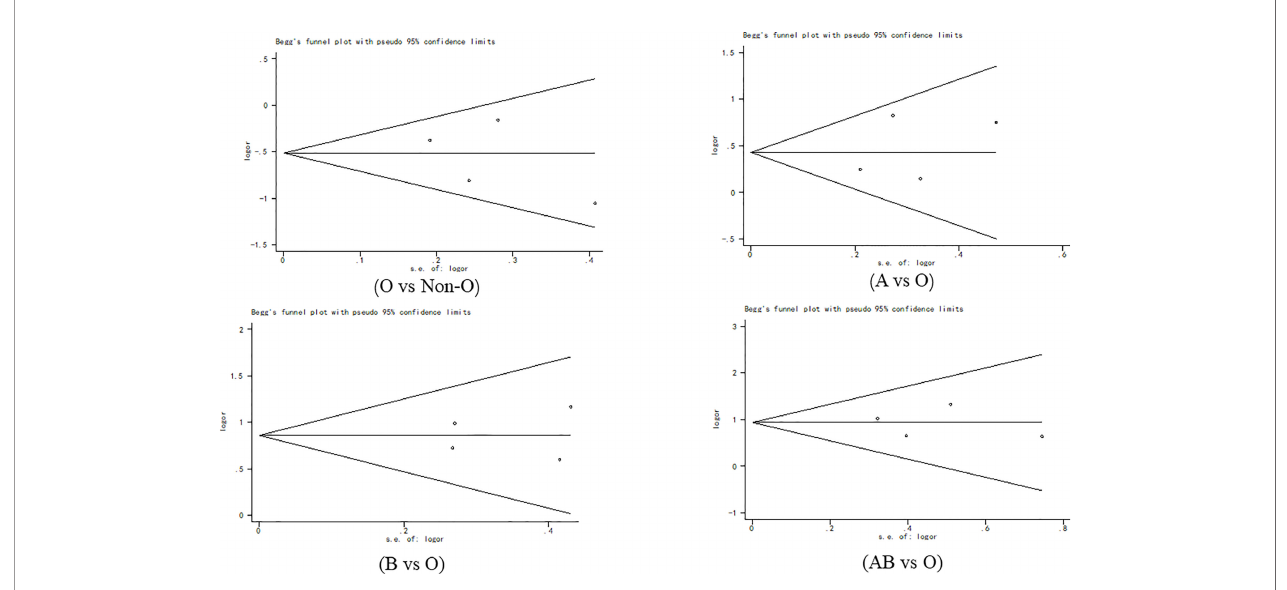
FIGURE 7 | Begg ’ s funnel plot for publication bias.